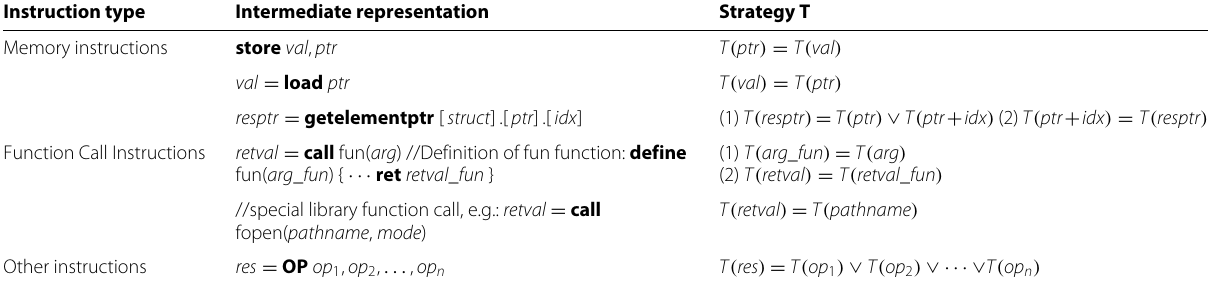
Table 1 The strategies of taint propagation for different kinds of instructions